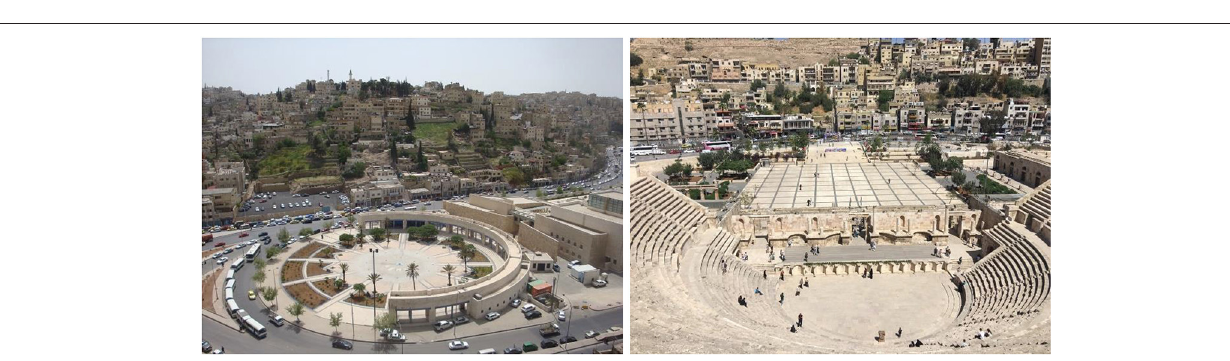
FIGURE 11 | The two plazas at both edges of the Amman Stream (the Palms Plaza at Ras al-‘Ain and the Hashemite Plaza by the Classical era Theater) are predominantly hard surfaces surrounded by car-oriented roads (photos by Dr. Luna